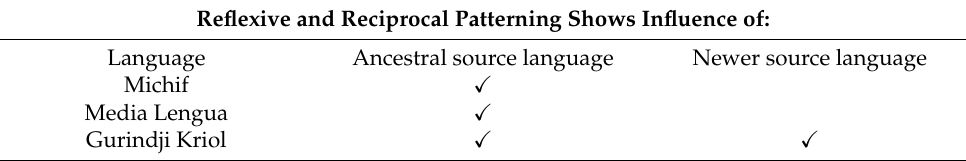
Table 1. Influence of source languages in reflexive and reciprocal patterning in three mixed languages. Reflexive and Reciprocal Patterning Shows Influence